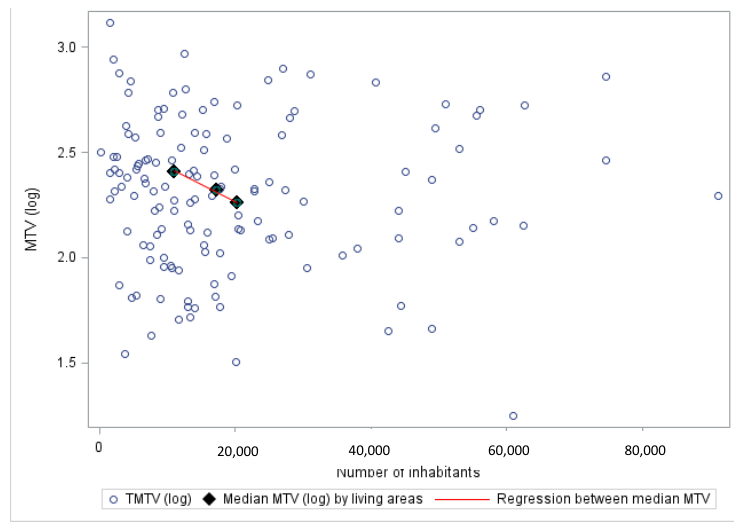
Figure 2. Correlation between the TMTV and the number of inhabitants in the town of patients who provided their ZIP codes. All sizes of towns are considered in the calculation, while for the visualization, the upper limit of the x-axis is 80,000. Abbrev: MTV. Metabolic Tumor Volume.